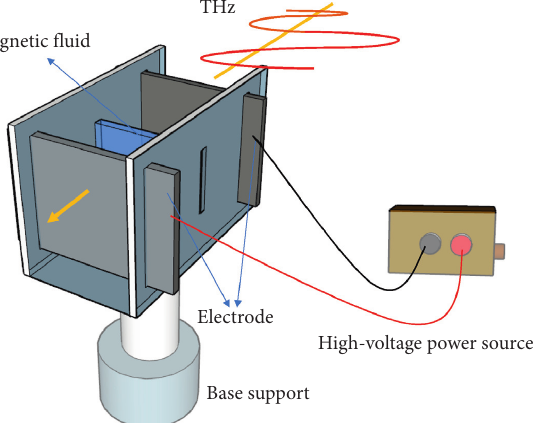
Figure 6: Diagram of the vertical electric field